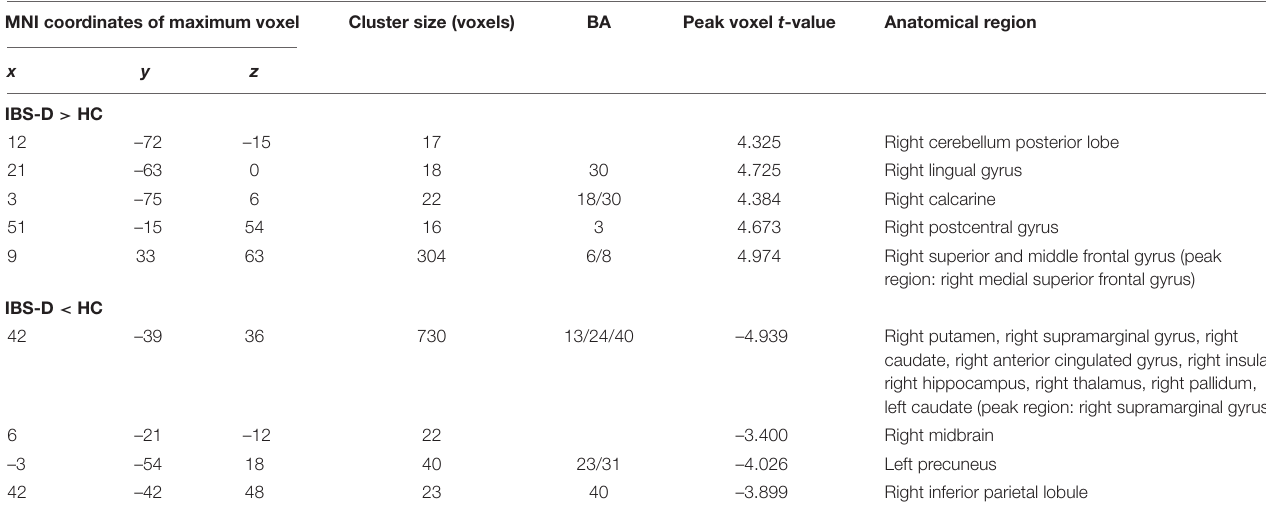
FIGURE 1 | Clusters showing ALFF changes in IBS-D patients as compared to that in healthy controls (TFCE, FWE-corrected P < 0.05). Blue color denotes relatively lower ALFF values in IBS-D group, red color denotes relatively higher ALFF values in IBS-D group, and the color bar in dicates the t -value from two-sample t -test between IBS-D group and HCs. L, left; R, right. TABLE 2 | Brain regions with abnormal ALFF in IBS-D patients compared to